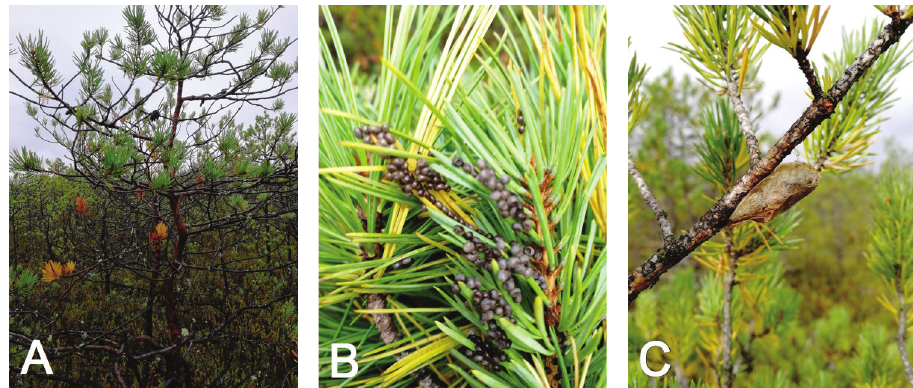
Figure 1. A partially defoliated pines B egg-laying and C Siberian moth pupal cocoon at the collection site (photo by L.